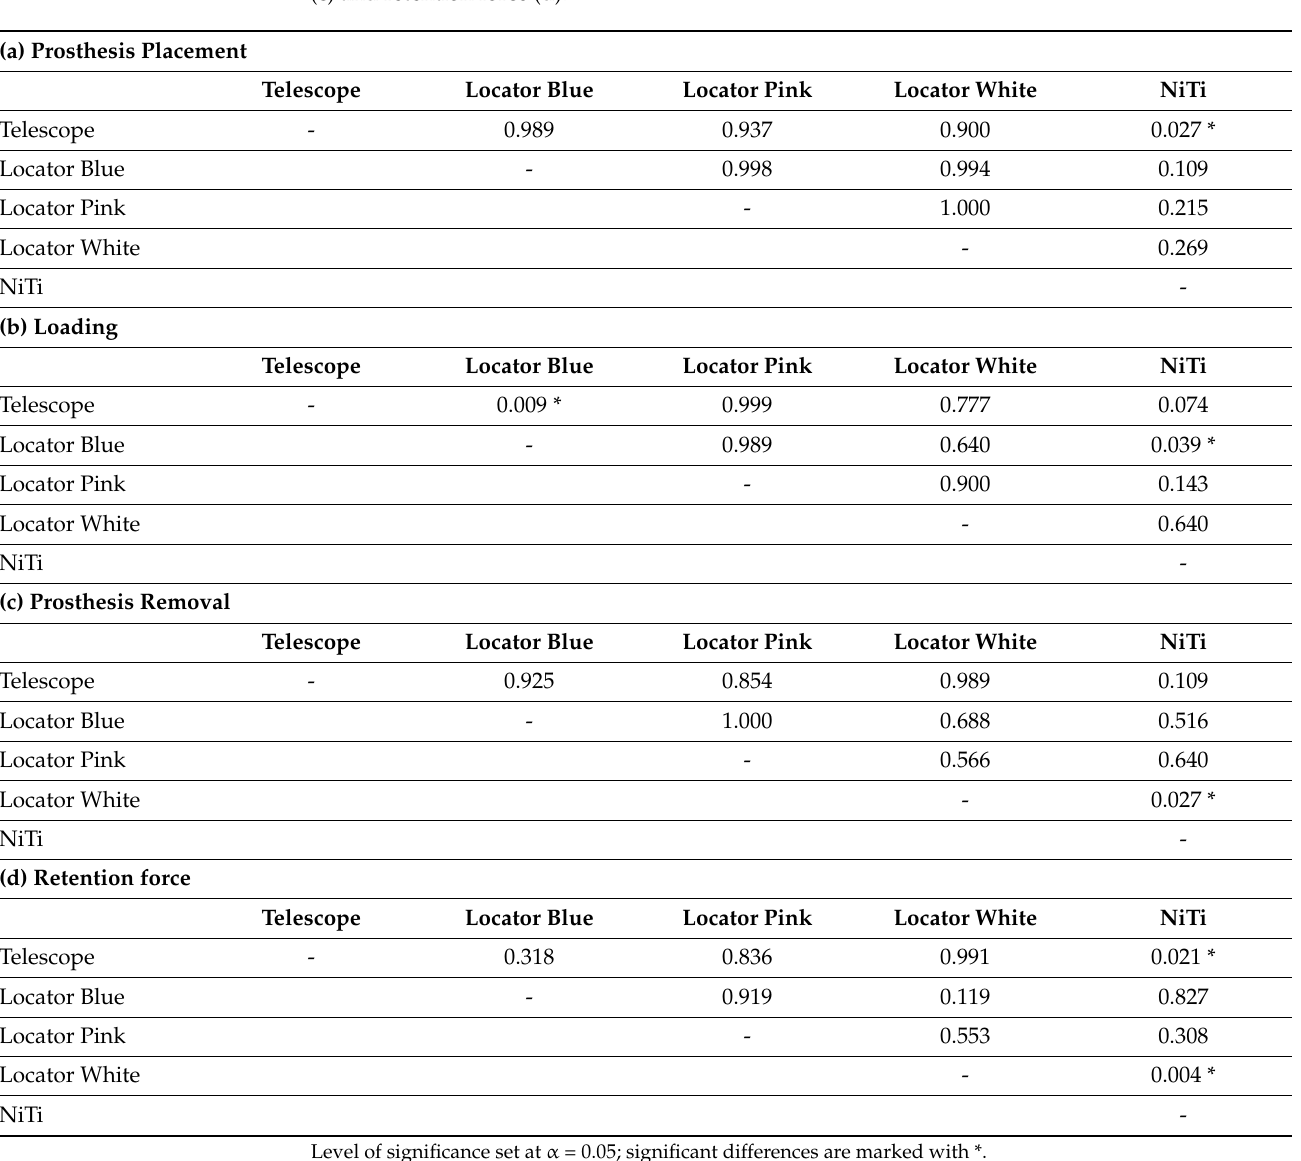
Table 3. Results ( p -value) of pairwise comparisons (Nemenyi’s all-pairs test; Bonferroni correction) between the attachment systems tested for prosthesis placement (a), loading (b), prosthesis removal (c) and retention force